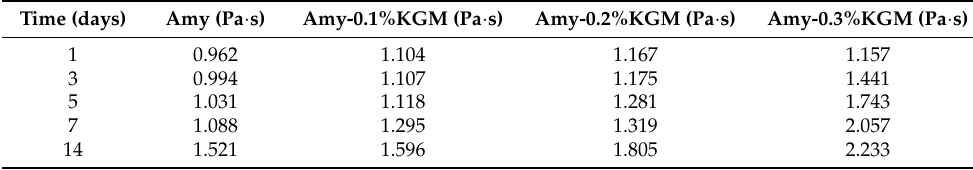
Table 1. Composite viscosity amylose–KGM mixtures fitted by the power law equation. Time